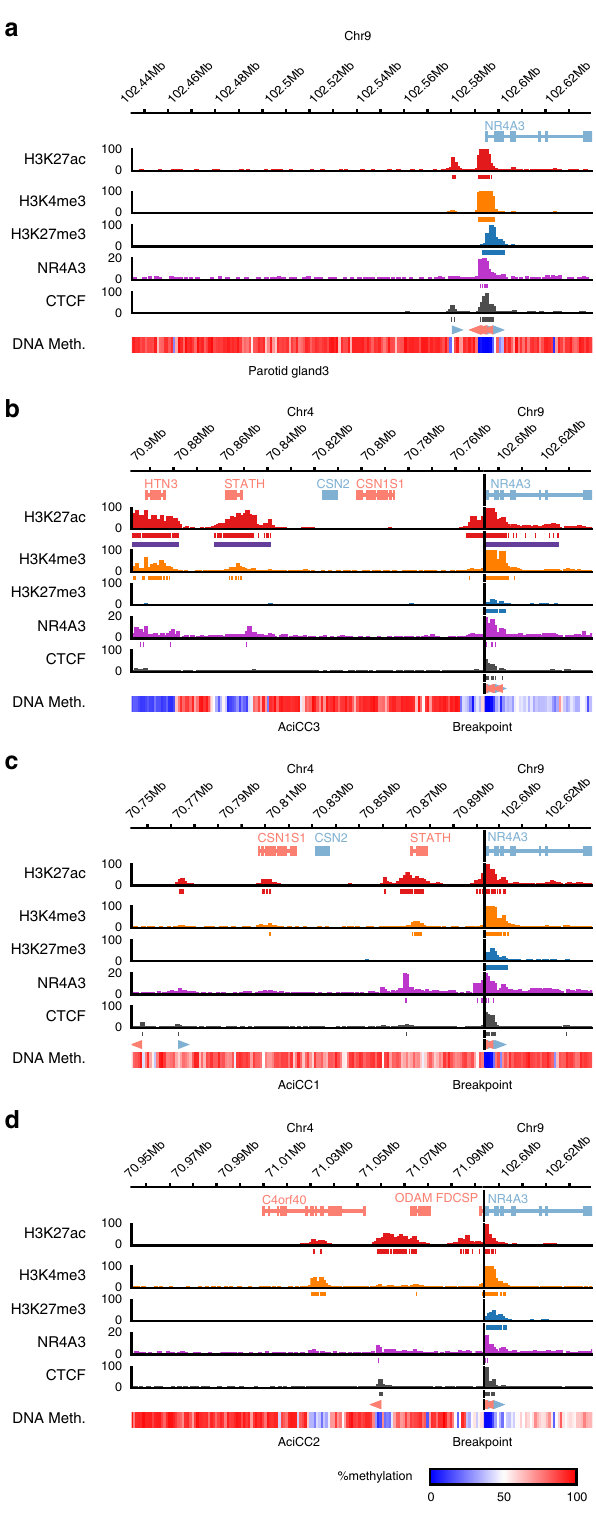
gland (SG) cells either with the human NR4A3 open reading frame (ORF) or with red fi re fl y luciferase coding regions and investigated molecular and phenotypic effects. First, we per- formed RNA-seq and whole mass spectrometry proteome ana- lysis for unbiased determination of mRNA expression (Supplementary Figure 6, Supplementary Data 5) and protein abundance (Supplementary Figure 7), respectively. Human